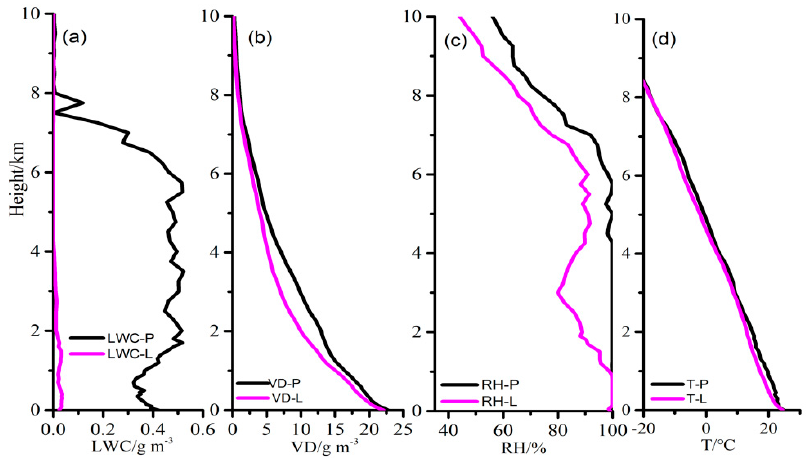
Figure 9. The vertical profiles of liquid water content (LWC) ( a ), vapor density (VD) ( b ), relative humidity (RH) ( c ), and temperature (T) ( d ) in the precipitation peak and CG flashes peak of Case 1. (p represents the peak pf precipitation at the time of 2030 LT; -L represents the maximum number of CG flashes at the 2300 LT on 14 May 2015).